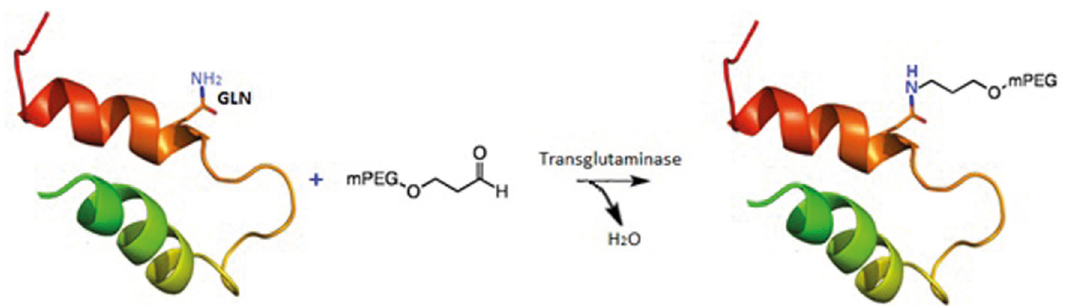
FIGURE 8 - Site-specific PEGylation of protein with transglutaminase (TGase) strategy, where GLN residue are PEGylated in the presence of